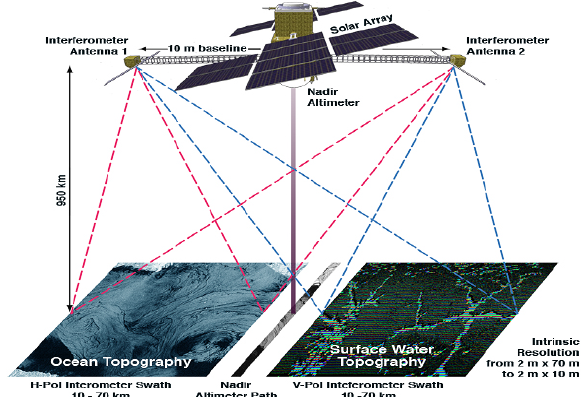
Figure 1. A schematic illustration of the SWOT measurement configuration. Credit: